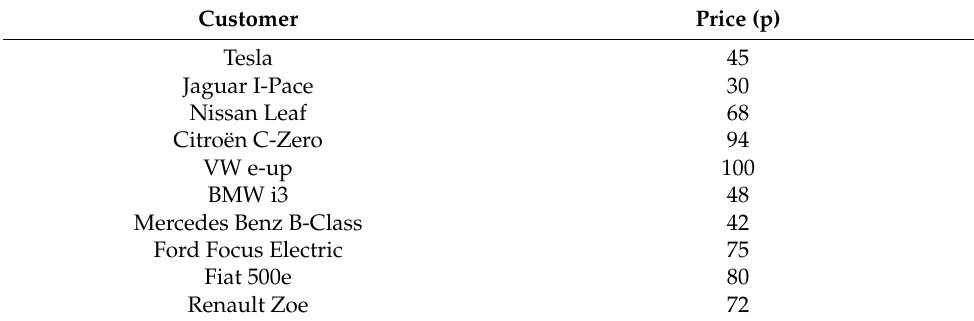
Table 9. Price customer is inclined to